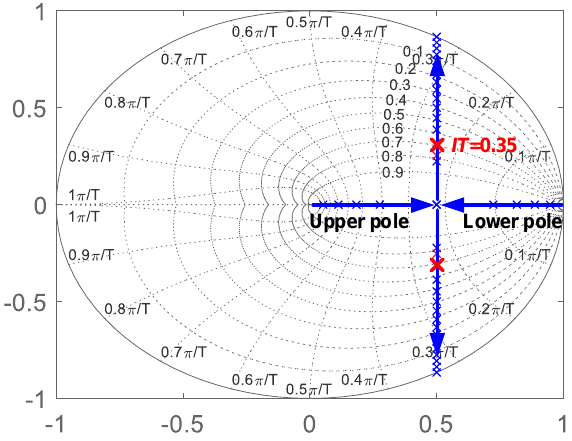
Φ ( z ) when IT changes from 0 to 1. Figure 8. Root locus of Φ( z ) when IT changes from 0 to 1. Figure 8. Root locus of